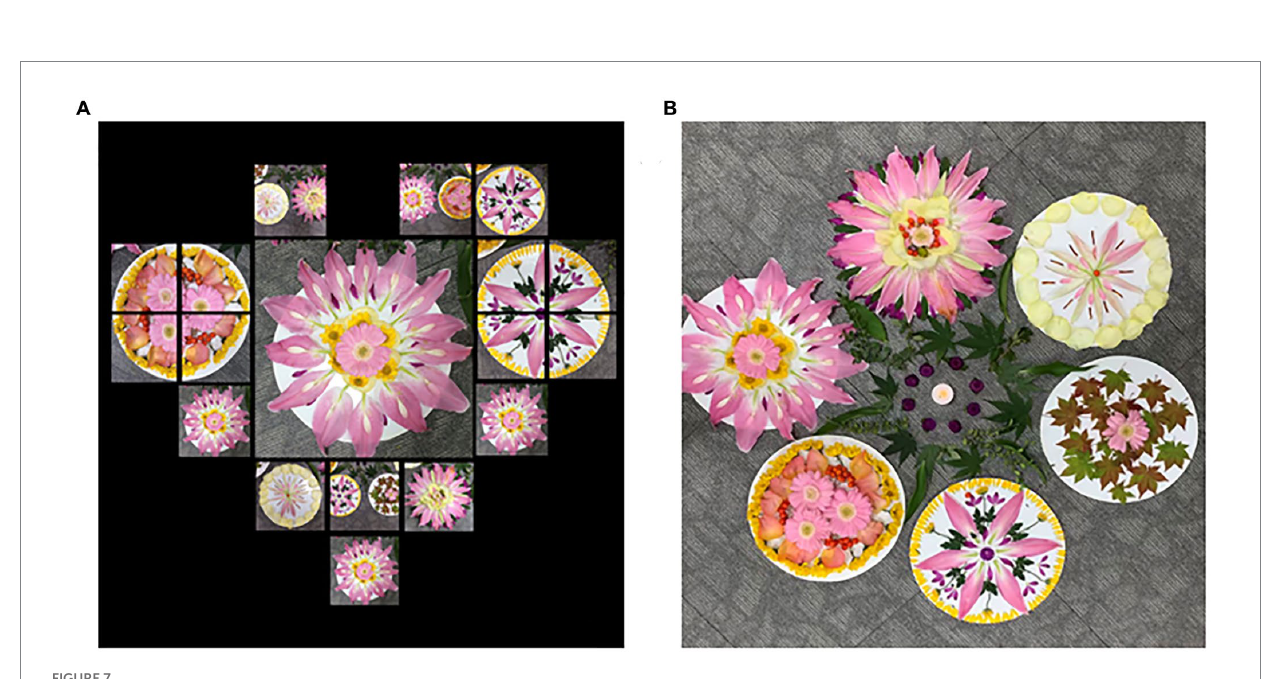
FIGURE 7 (A) Pink’s “Photo collage”. (B) Our garden (collaborative